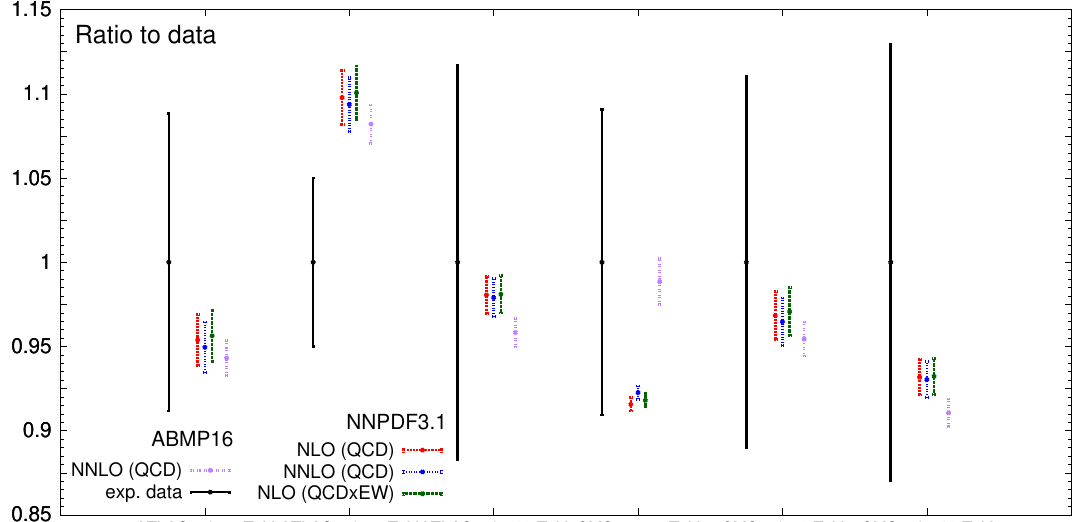
Figure 2 . The total t -channel single top-quark and top-antiquark cross sections and their ra- tios from ATLAS and CMS analysed in this work (see table 1). The measurements are compared to theoretical predictions computed at NLO and NNLO in pure QCD, and at NLO in mixed QCD and EW theories. The corresponding sets of PDFs from the NNPDF3.1 determination are used: NNPDF31 nlo as 0118 , NNPDF31 nnlo as 0118 , and NNPDF31 nlo as 0118 luxqed , respec- tively. For NNLO QCD theory, an alternative PDF set that includes some of the data in table 1, ABMP16als118 5 nnlo , is also used for comparison (see text for details). Both the data and the theoretical predictions are normalised to the central value of the data. Error bars on the data correspond to the square root of the sum in quadrature of statistical and systematic uncertainties; error bars on the theoretical predictions correspond to the 68% CL PDF